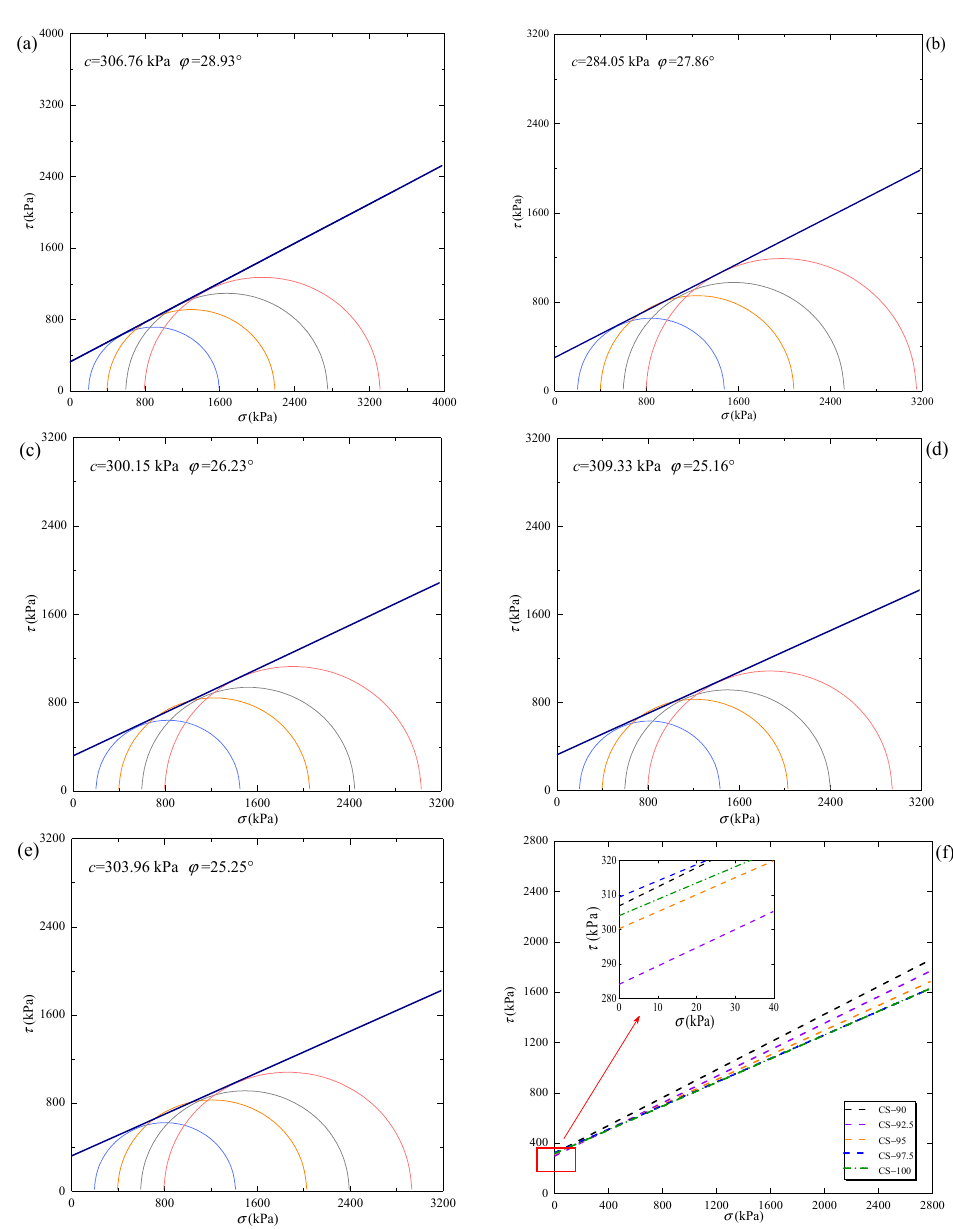
Figure 12. The shear strength envelope curves of: ( a ) CS–90; ( b ) CS–92.5; ( c ) CS–95; ( d ) CS–97.5; ( e ) CS–100; and ( f ) the comparison.